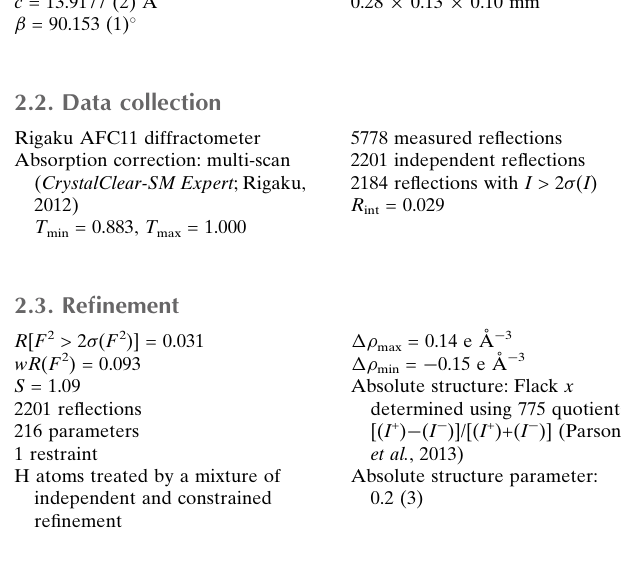
Hydrogen-bond geometry (A˚ , (cid:2)